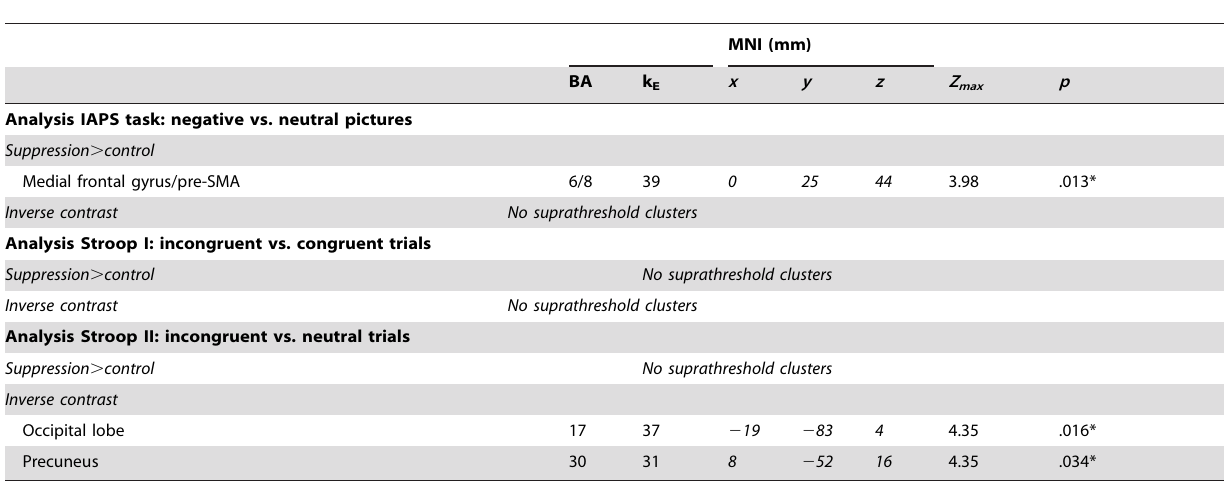
Table 2. Results of the exploratory whole brain analysis for each task